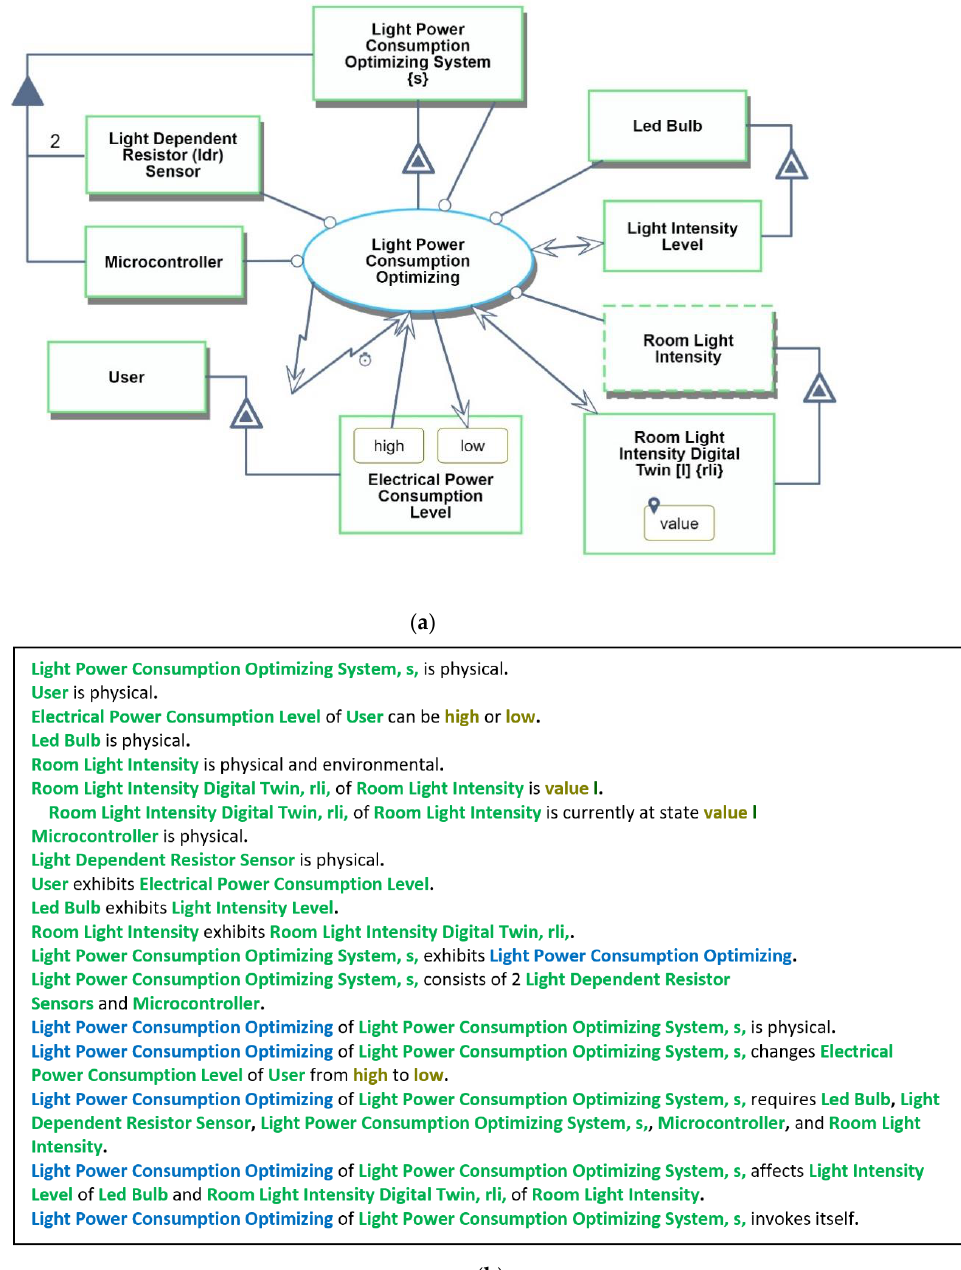
Figure 15. Optimal Light Power Consumption System. ( a ) System Diagram (SD). ( b ) The OPL paragraph of SD.